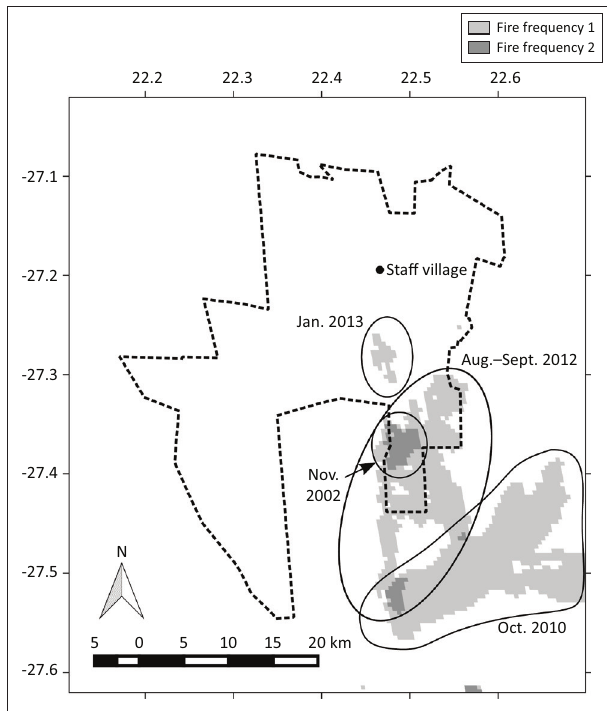
FIGURE 6: The frequency of fire from 2000–2001 to 2014–2015 growth seasons as determined from the Moderate Resolution Imaging Spectroradiometer burned-area products (MCD45A1) in the Tswalu Kalahari Reserve. The data show that in the past 15 years the burned areas have been confined to the mountains in the south-eastern corner of the reserve. The dates on the map indicate the year and month in which the fires